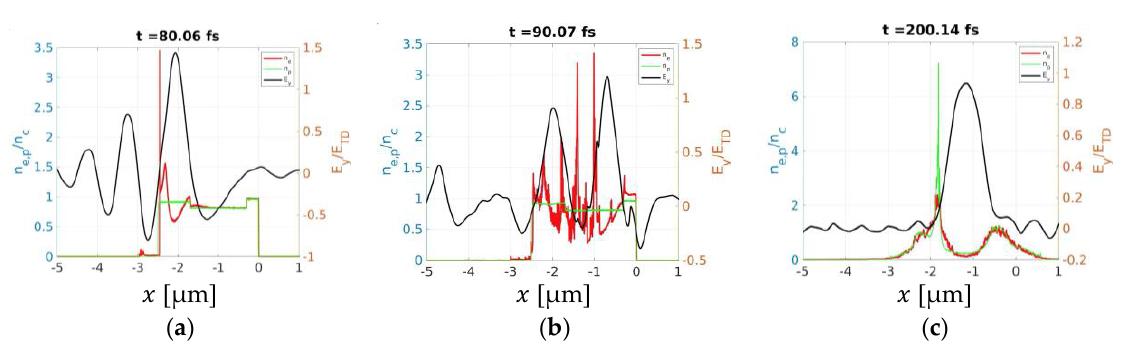
Figure 3. Snapshots of the spatial profiles of the electron density (red), proton density (green), and transverse electric field (black) at 80 fs, 90 fs, and 200 fs, respectively, for a_0 = 1 laser for the case of the tailor region only. The laser pulse enters the trapping region and strongly modifies the local electron density while ion density remains unperturbed ( a ) and penetrates the trapping region and is partially trapped ( b ) while only the electron density is perturbed. Ion density is strongly perturbed later in the evolution ( c ) with the laser pulse converted into a half cycle pulse; however, part of the laser energy is transmitted to the right.